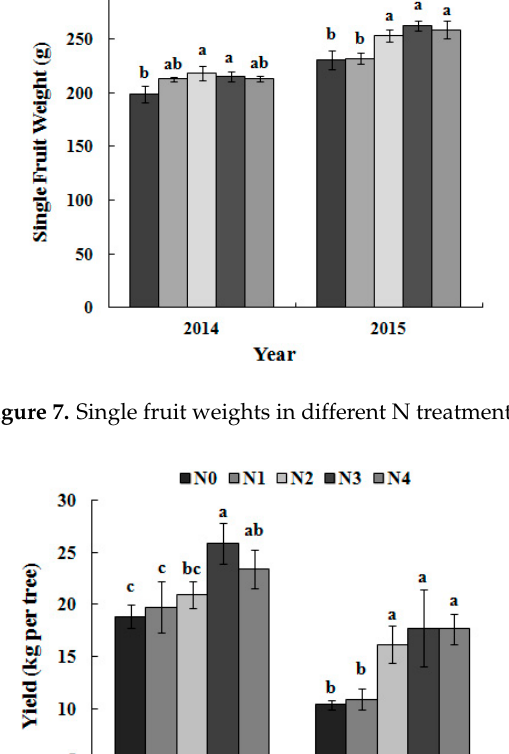
Figure 6. Leaf nitrogen concentrations at the fruit expansion stage in 2014 ( a ) and 2015 ( b ). Every point is an average of 60–80 leaves. Vertical bars represent ± SE.